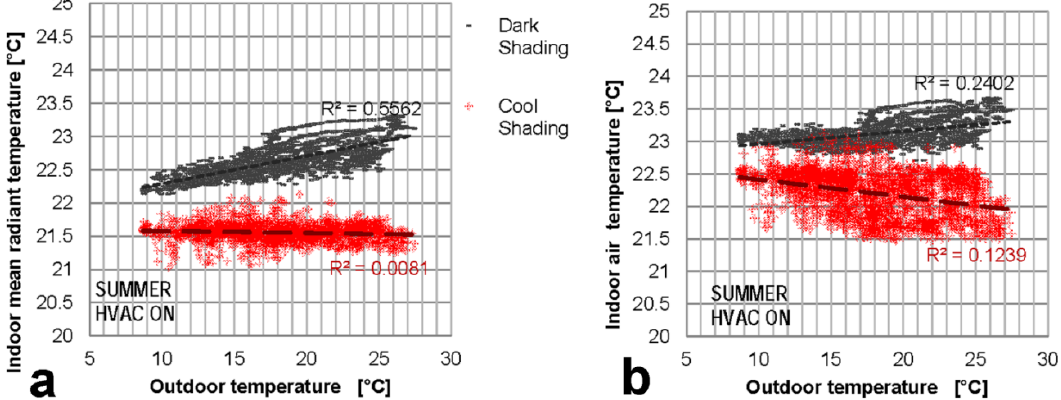
Figure 8. Indoor thermal comparative assessment of the two configurations in terms of ( a ) mean radiant temperature and ( b ) air temperature, when the HVAC system is operative.